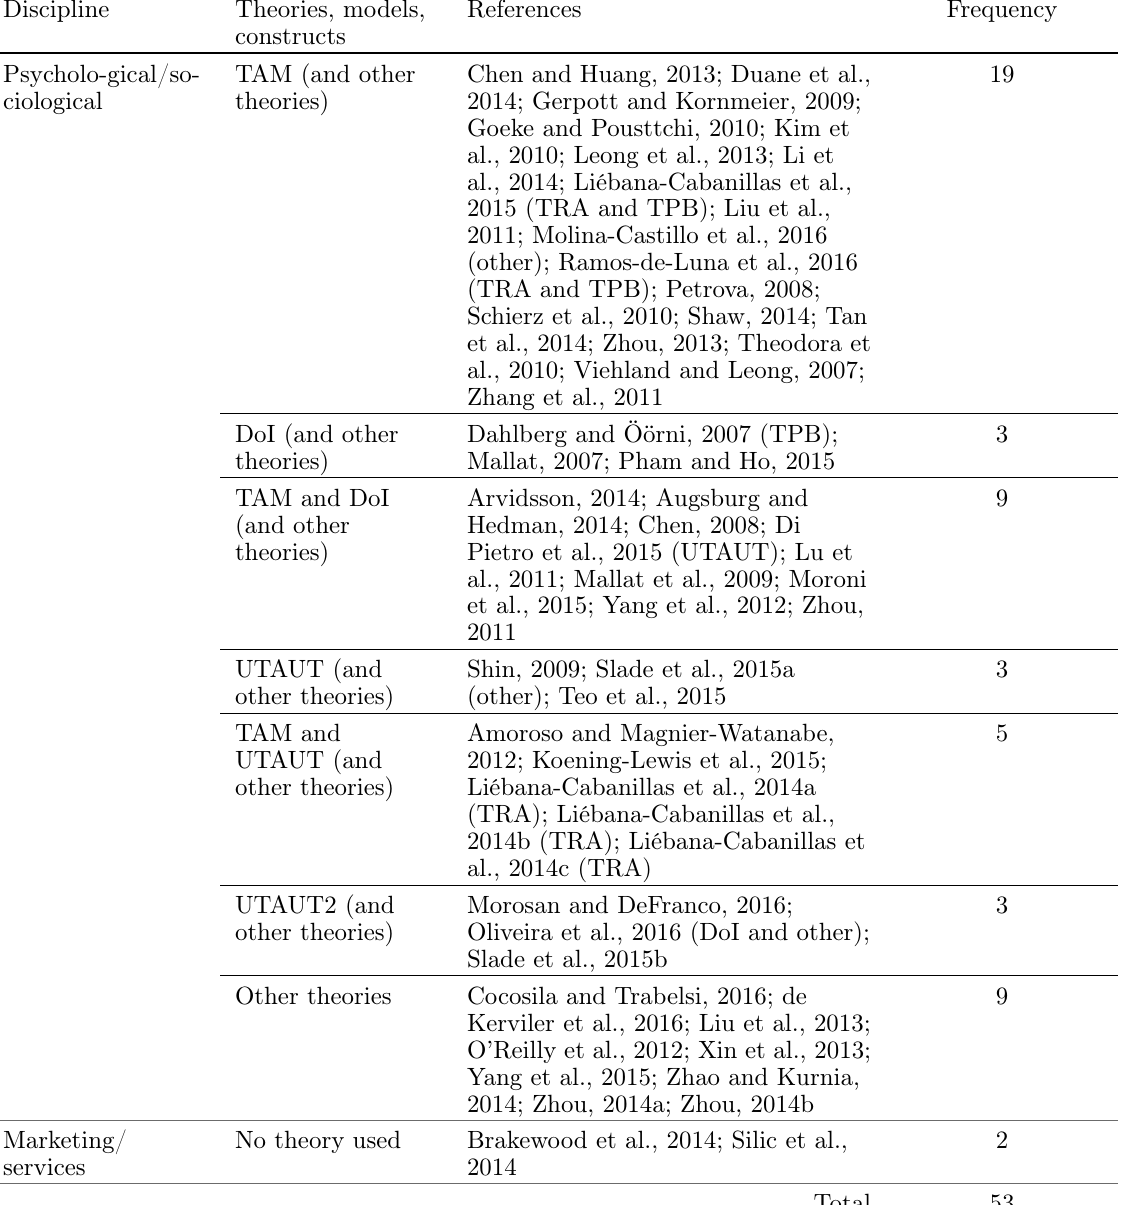
Theoretical perspectives used in research on customer adoption of mobile pay-